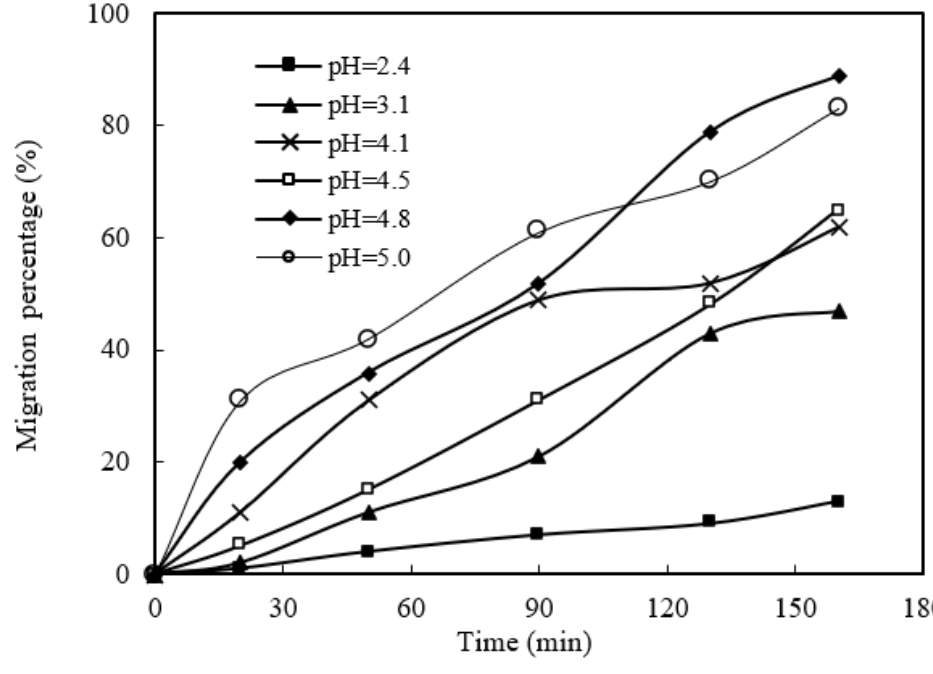
Figure 7. Effect of sewage pH.